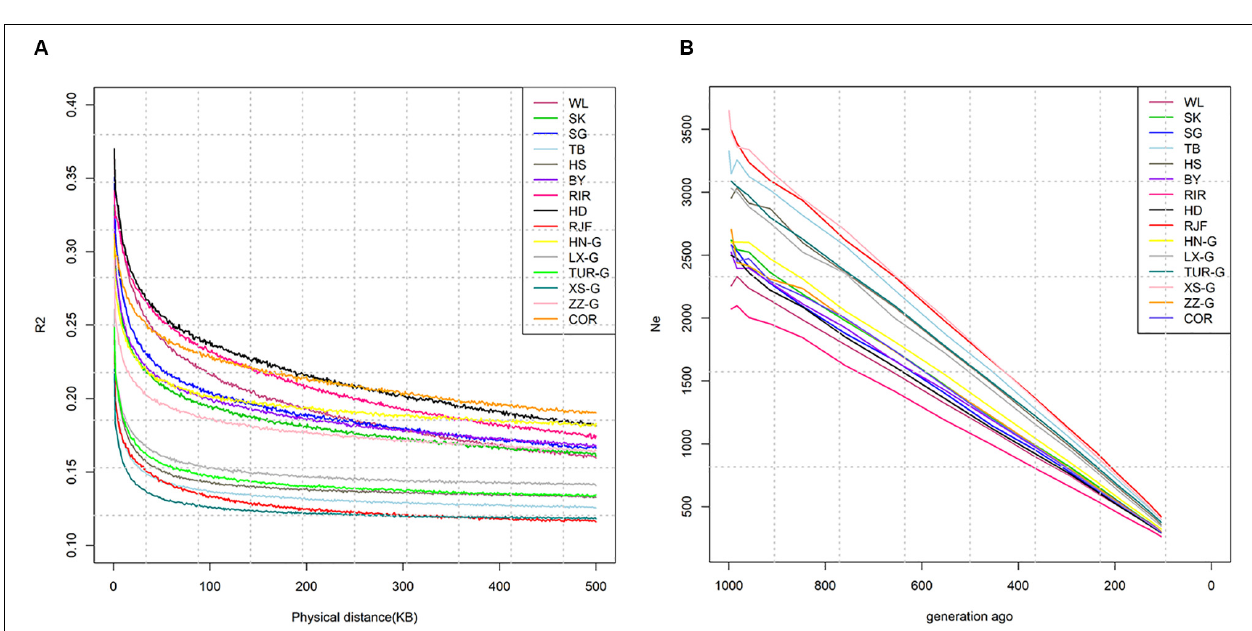
FIGURE 3 | Manhattan plot of occurrences (%) of a SNP in the runs of homozygosity for per breed.